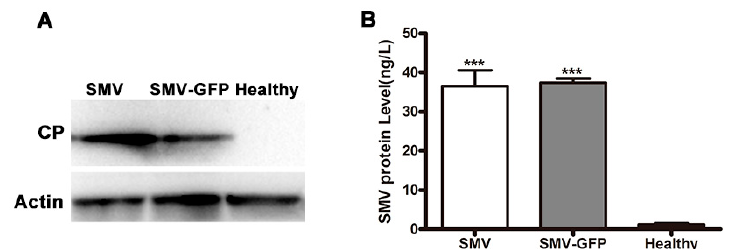
Figure 3. Detection of SMV protein and virus accumulation for two infectious clones in plants. N. benthamiana plants were inoculated with SMV or SMV-GFP infectious clones, and the infected leaves were collected 5 dpi for total protein isolation. ( A ) Detection of SMV CP protein via Western blotting. The internal reference protein actin was used as a control. CP, 29 kDa; actin, 48 kDa. ( B ) Detection of SMV accumulation via ELISA. T-test was performed between healthy and SMV or SMV-GFP infected plants. Triple asterisks, p < 0.001.